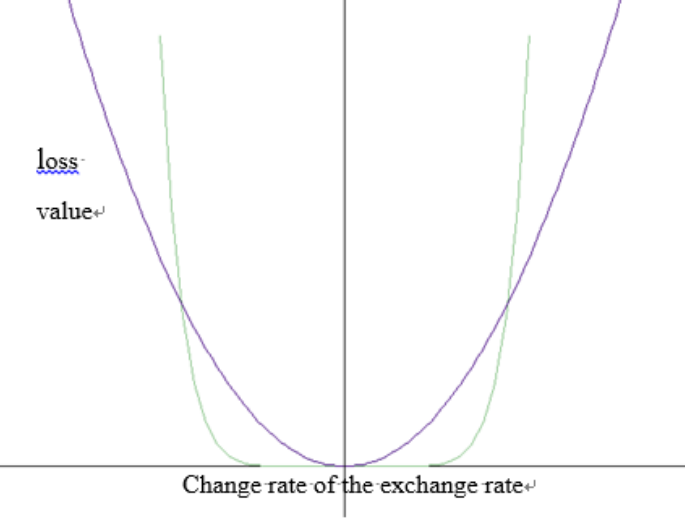
Fig. 1 Range Quadratic Preference Function and Quadratic Preference